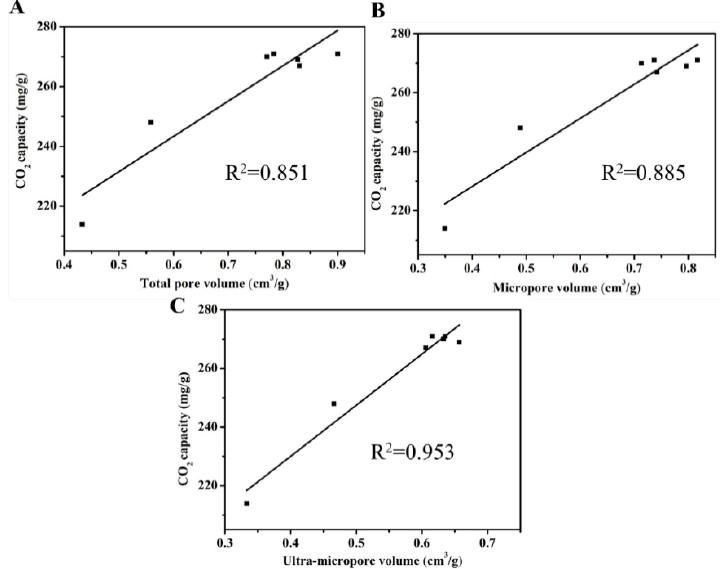
Figure 7. Relationships between CO 2 capacities and total pore volume ( A ), micropore volume ( B ), and ultra-micropore volume ( C ).